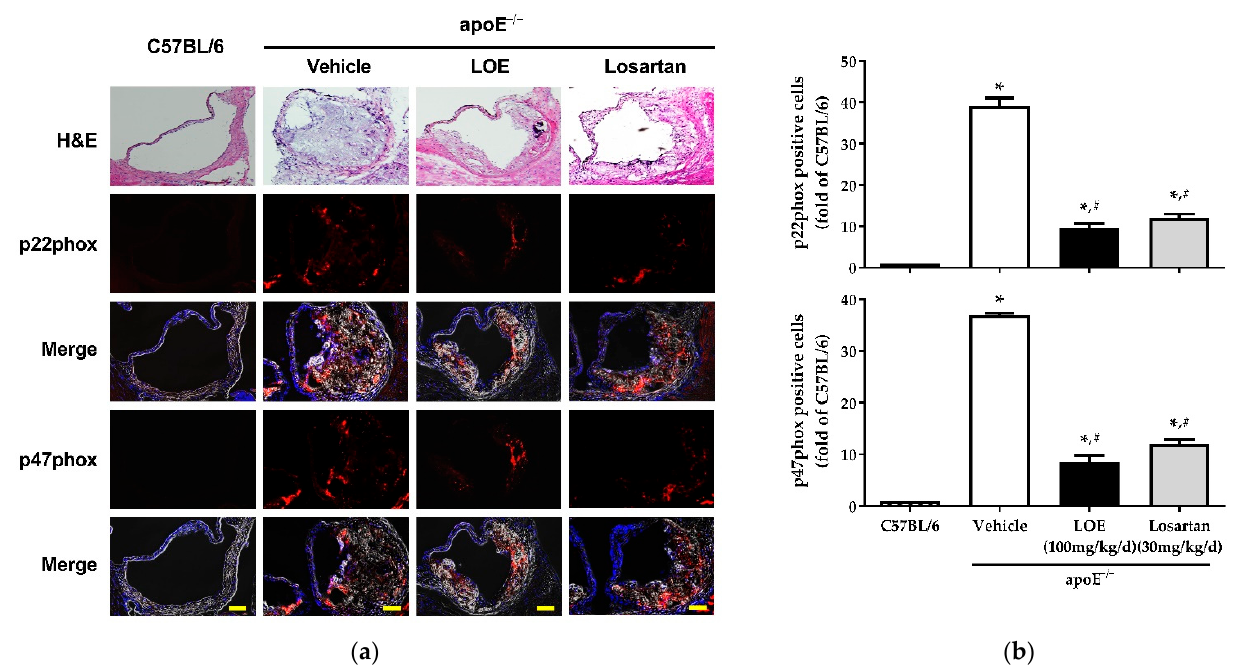
Figure 3. LOE and losartan treatments inhibit NADPH oxidase subunits p22phox and p47phox in aortic sections obtained from apoE − / − mice. The expression of the NADPH oxidase subunits p22phox and p47phox was determined by confocal microscopy using a purified polyclonal antibody and a fluorescence-tagged secondary antibody. Nuclei were stained with DAPI (blue). ( a ) Representative images show H&E staining (top), p22phox and p47phox staining in red (middle), and merged fluorescence staining and DAPI (bottom). ( b ) Corresponding cumulative data. The scale bar represents 100 µm. The results are shown as mean ± SEM (n = 4–6). * p < 0.05 versus the C57BL/6 group and # p < 0.05 versus the apoE − / − vehicle group.